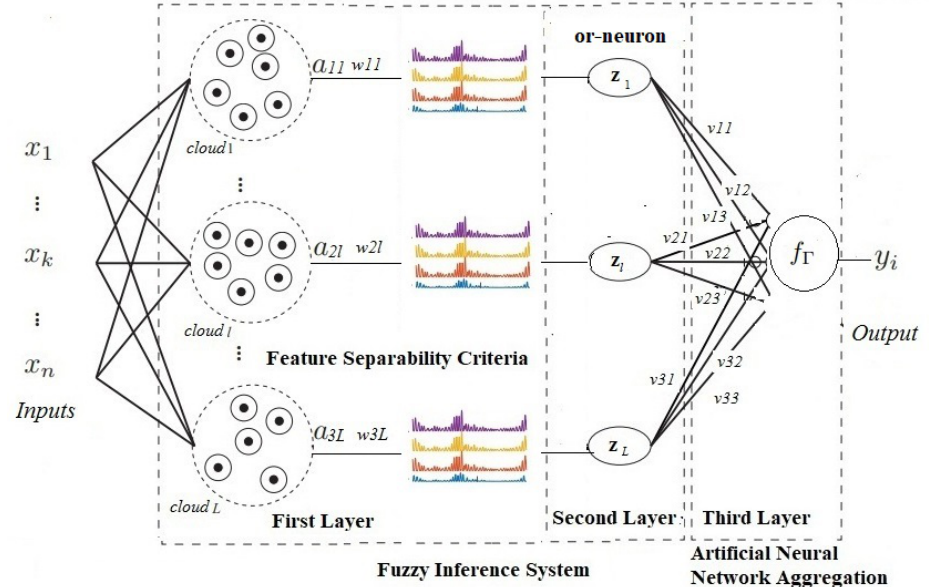
Figure 3. Architecture of the fuzzy neural network proposed in this